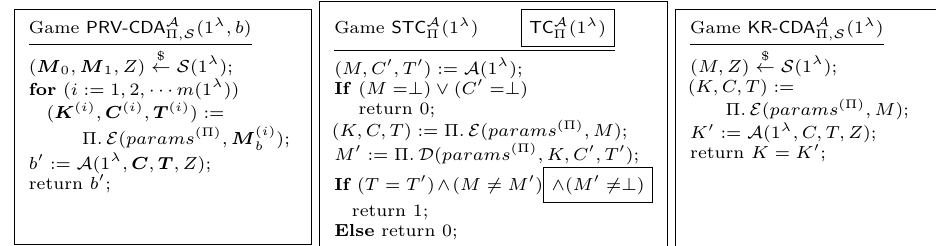
Figure 1: Games defining PRV-CDA , STC , TC and KR-CDA security of MLE scheme Π = (Π . E , Π . D